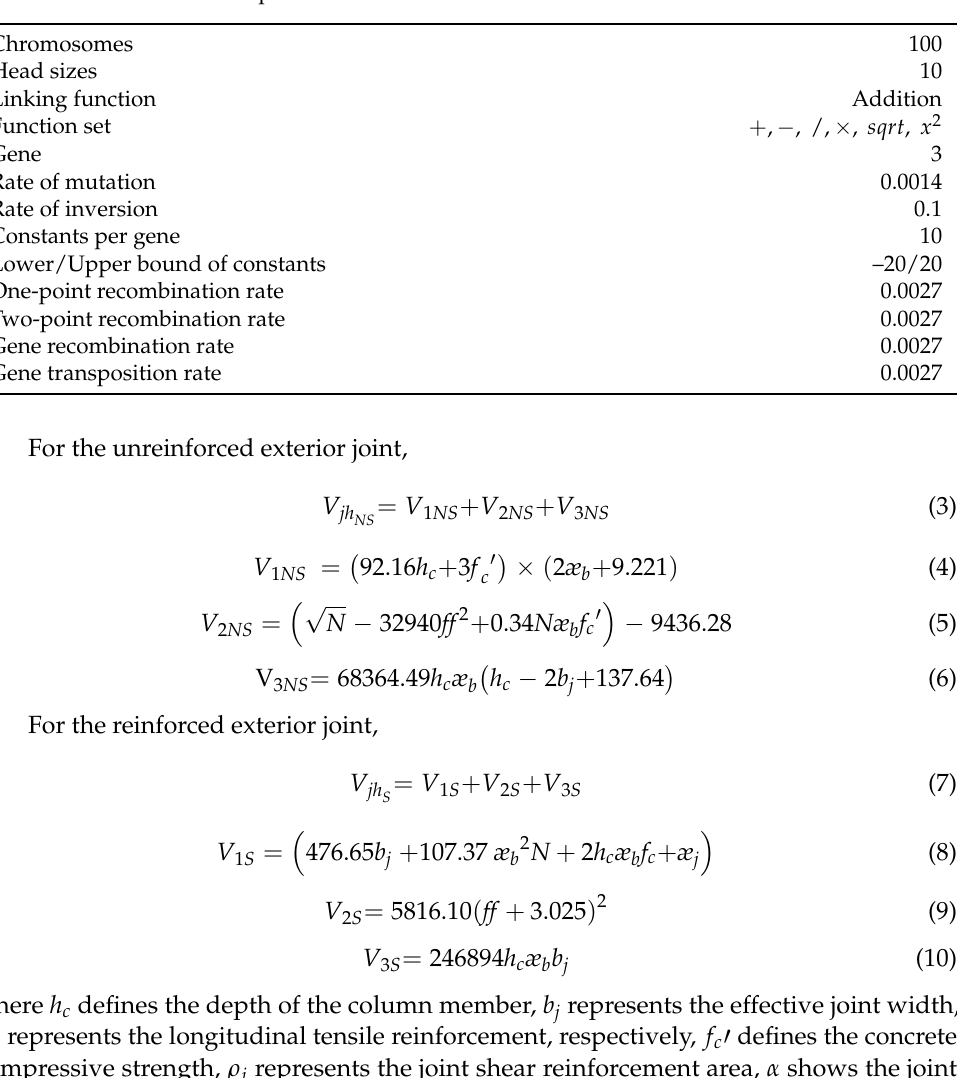
Table 2. Model construction